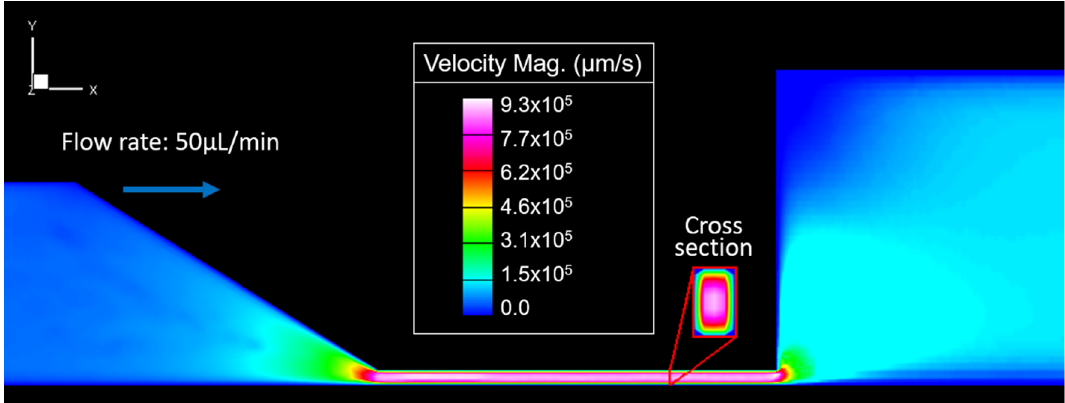
Figure 3. Velocity magnitudes along the channel represented by a color gradient. inlet channel distributed along the cross-section and suspended in a Newtonian fluid.